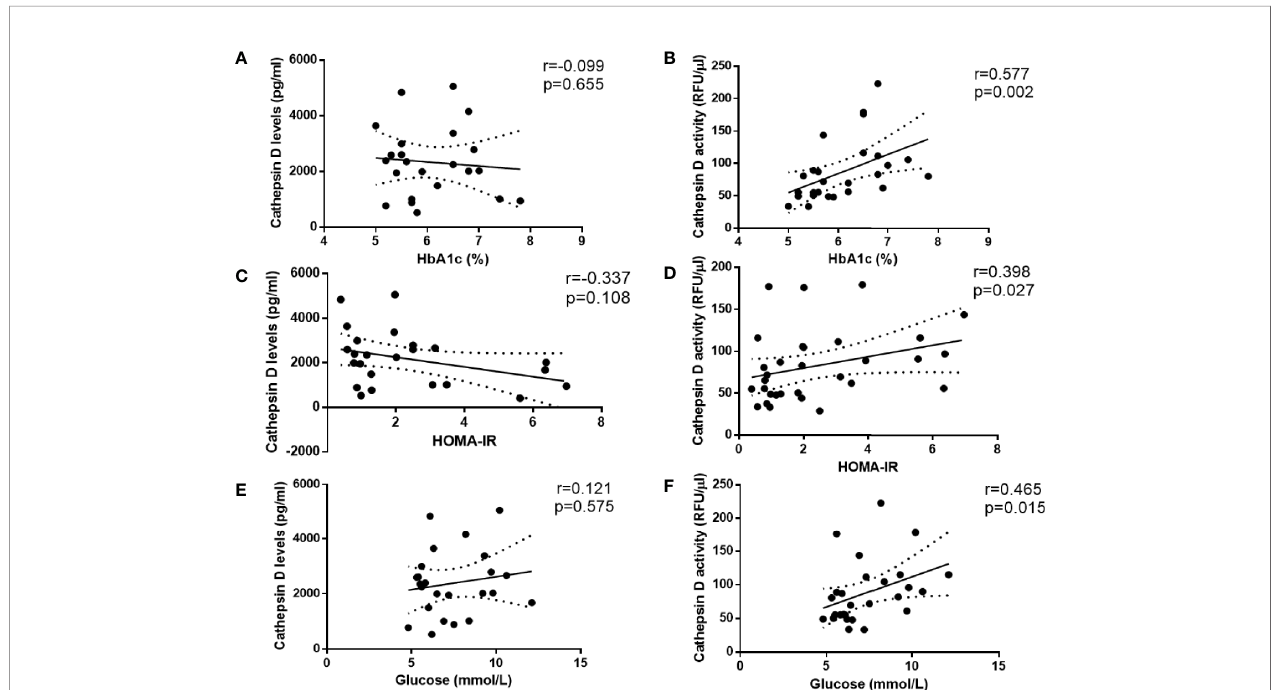
FIGURE 3 | Spearman correlations between CTSD levels and activity versus type 2 diabetes-indicators in male individuals. CTSD levels (A, C, E) or activity (B, D, F) vs. HbA1c (%), HOMA-IR and glucose (mmol/L), respectively. Spearman ’ s correlations were performed. p < 0.05 is considered statistically signi fi